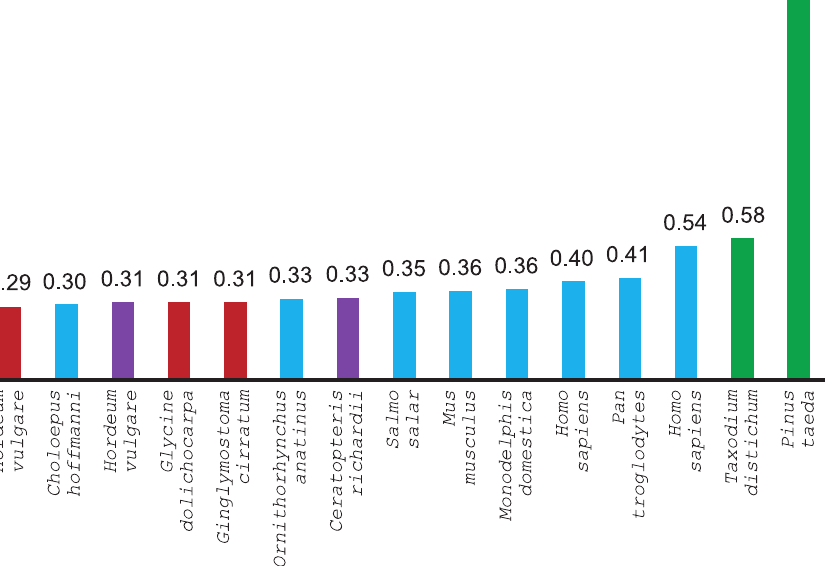
Figure 1. Clone numbers (in millions of clones) for the largest BAC libraries. The Pinus taeda BAC library is three times larger than the second largest library. Bar colors represent the center/institute at which the library was made – red represents the Arizona Genomics Institute (AGI; www.genome.arizona.edu), blue the Children’s Hospital of Oakland (CHORI; http://bacpac.chori.org), purple the Clemson University Genomics Institute (CUGI; www.genome.clemson.edu), and green the Mississippi Genome Exploration Laboratory (MGEL; www.mgel.msstate.edu).